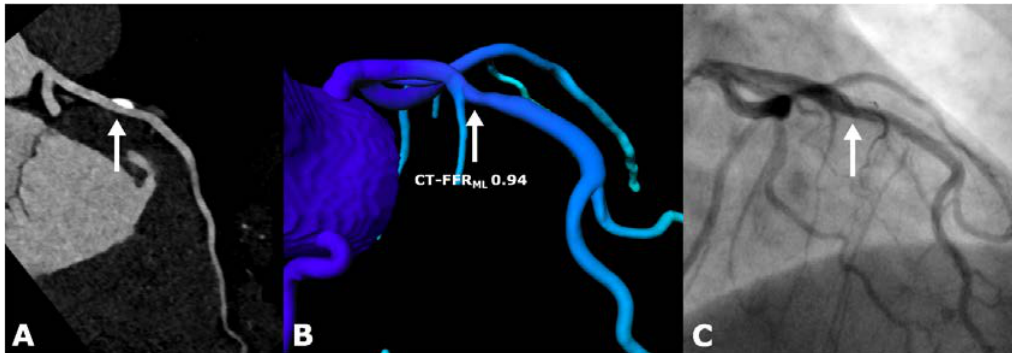
Figure 1. 53 year old female patient with suspected coronary artery disease (CAD) and a history of smoking. ( A ) Calcified plaque of the mid left anterior descending artery (LAD) in a sectional image by coronary computed tomography angiography (cCTA) (arrow). ( B ) The computed-tomography-derived fractional flow reserve (CT-FFR ML ) software (cFFR, version 3.1, Siemens Healthineers, Forchheim, Germany) illustrates a 3D-model of the mid LAD with a not-flow-limiting stenosis and a CT-FFR ML value of 0.94 (arrow). ( C ) Invasive coronary angiography shows a mild stenosis in the mid LAD (arrow).